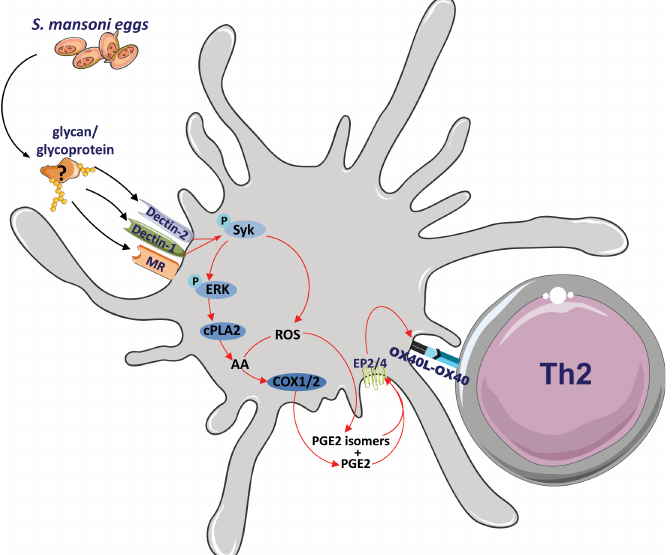
Fig 8. Proposed model of S . mansoni –driven Th2 polarization. S . mansoni egg antigens, but not ω -1, interact with Dectin-1 and Dectin-2 expressed by DCs to promote 2 intracellular pathways in moDCs in an Syk-dependent manner: ERK-cPLA 2 -COX and ROS activity that culminate in PGE 2 and PGE 2 isomer synthesis, respectively. Both PGE 2 and its isomers can then bind to EP2 and EP4 in an autocrine loop to trigger OX40L expression, which endows the DCs with the capacity to prime a Th2 response. ω -1, omega-1; COX, cyclooxygenase; cPLA 2 , cytosolic phospholipase A 2 ; DC, dendritic cell; EP2, prostaglandin E 2 receptor 2; ERK, extracellular signal-regulated kinase; moDC, monocyte-derived DC; OX40L, OX40 ligand; PGE 2 , prostaglandin E 2 ; ROS, reactive oxygen species; Syk, spleen tyrosine kinase; Th2, T helper 2.